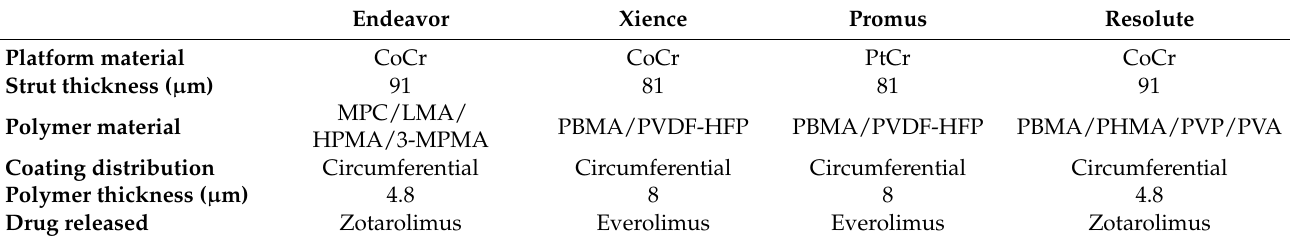
Table 1. Main features of durable-polymer drug-eluting